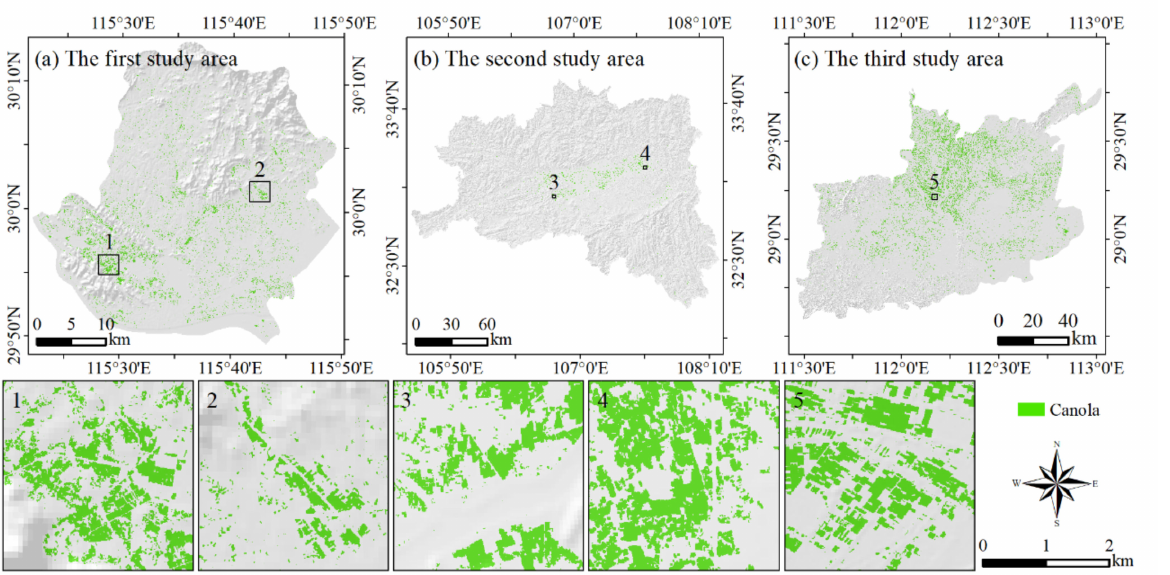
Figure 7. Distribution of canola planting regions in the three study areas in 2020. ( a – c ) The canola map in the first, second, and third study area respectively.